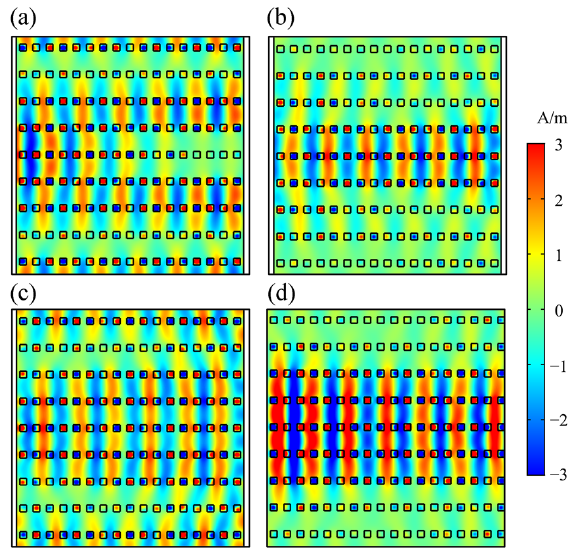
Figure 4. Light propagation in the HMM PhC membrane at different operating frequencies of ( a ) 550 THz, ( b ) 554.57 THz, ( c ) 560 THz, and ( d ) 554.57 THz. The observed beam behaviors at 550, 554.57, and 560 THz represent divergence, collimation, and convergence, respectively.